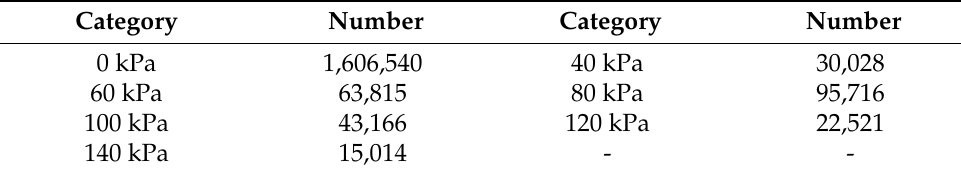
Table 4. Number of samples for each category in the data